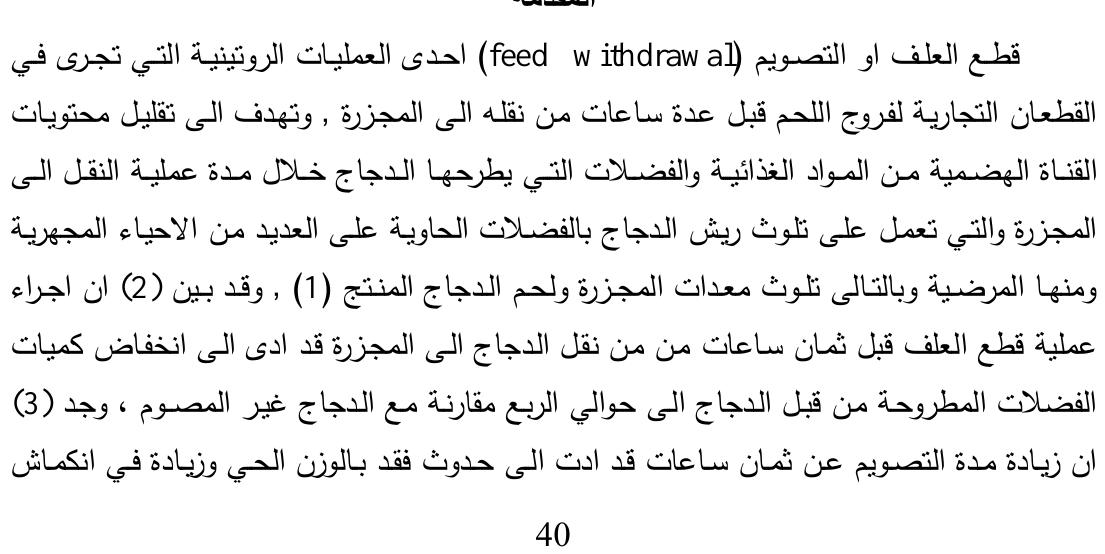
SSttuuddyy TThhee EEffffeecctt OOff FFeeeedd WWiitthhddrraawwaall AAnndd AAddddiinngg